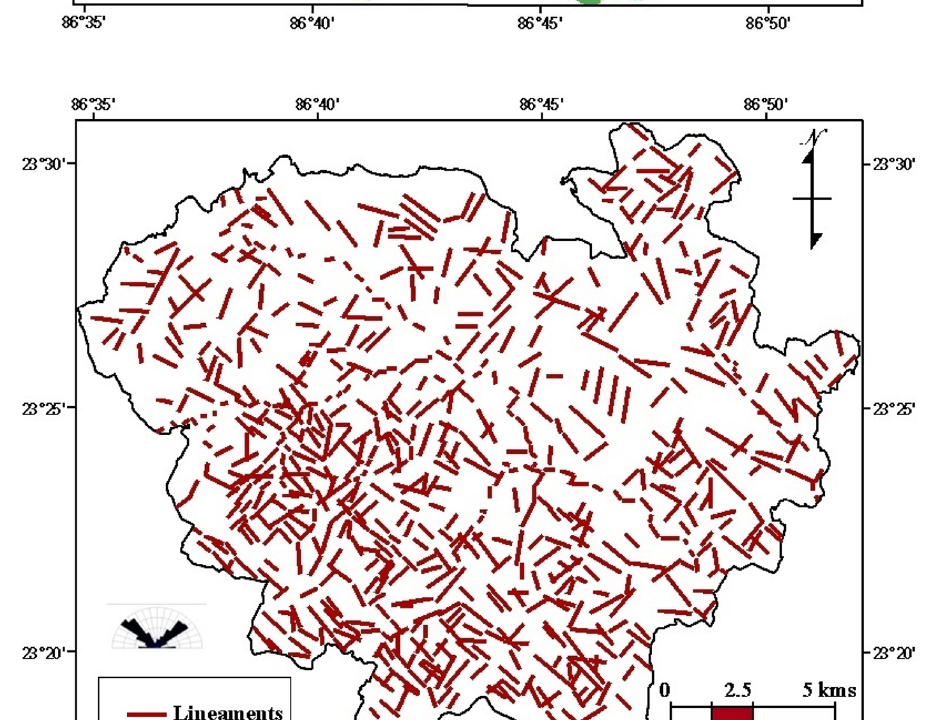
Fig. 7 Map showing lineaments of the study